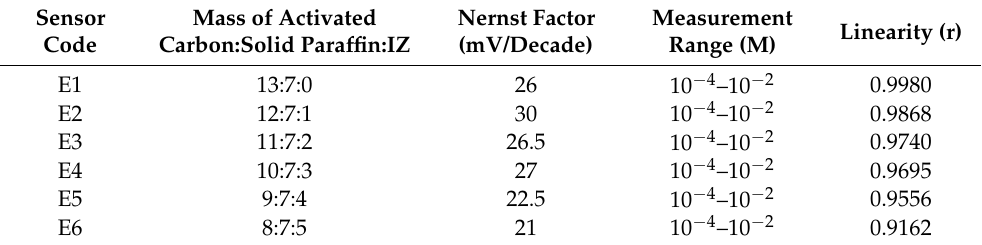
Table 3. Data on the Nernst factor, measurement range, and linearity of glucose solution variations in sensor composition.